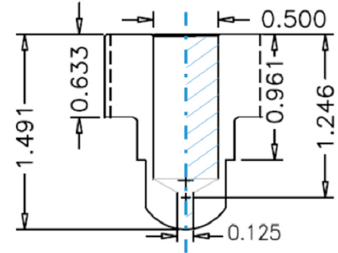
Figure 4. Geometric dimensions of a Strangpresse Model-19 extruder nozzle.